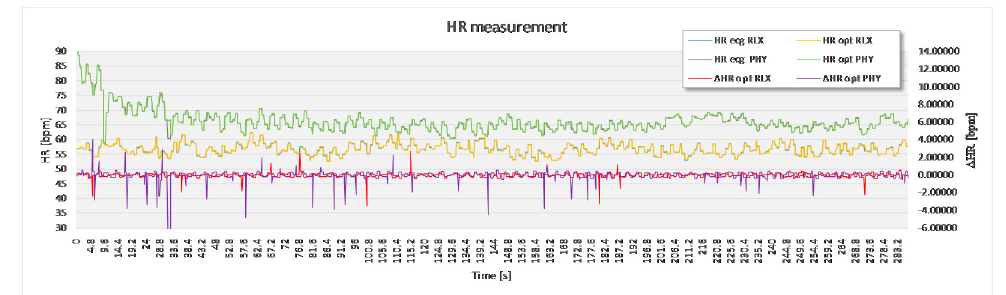
Figure 12. Recorded signal in laboratory experiment for subject 5.